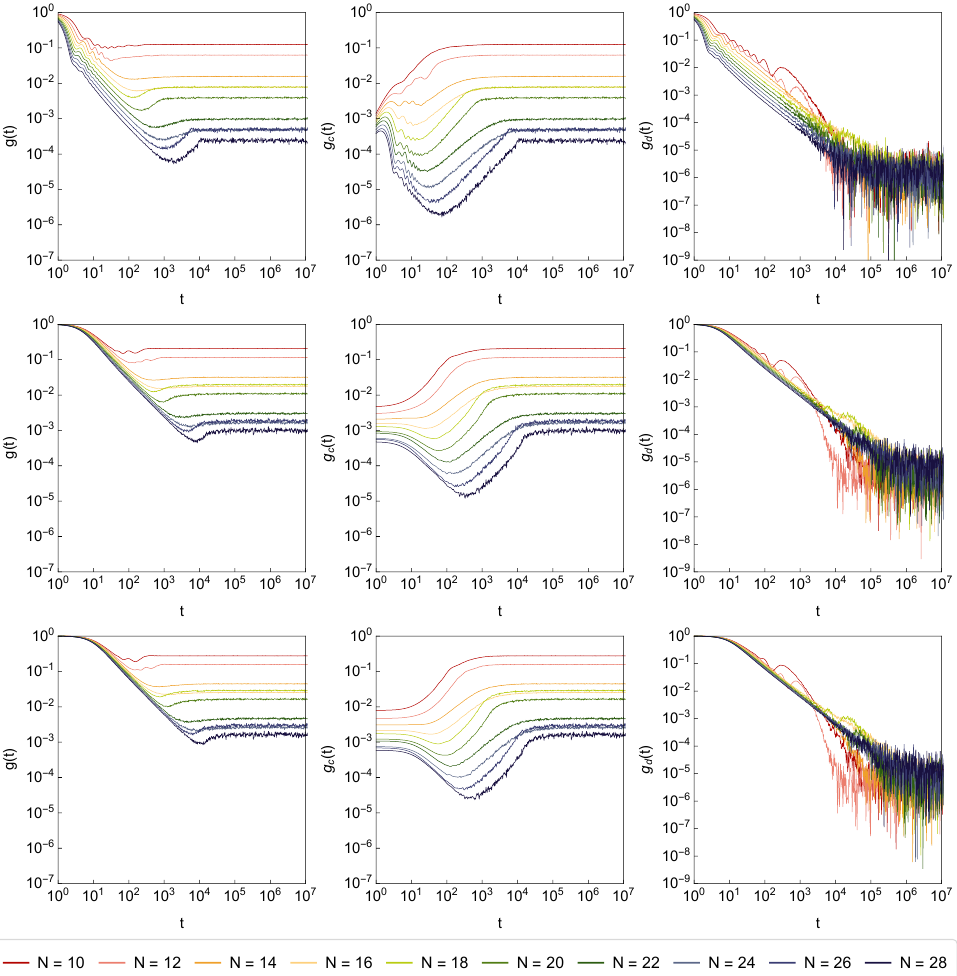
Figure 5 . The spectral form factors g ( t ), g c ( t ) and g d ( t ) in the supersymmetric SYK model with J N =1 = 1, (cid:12) = 0 ; 5 ; 10